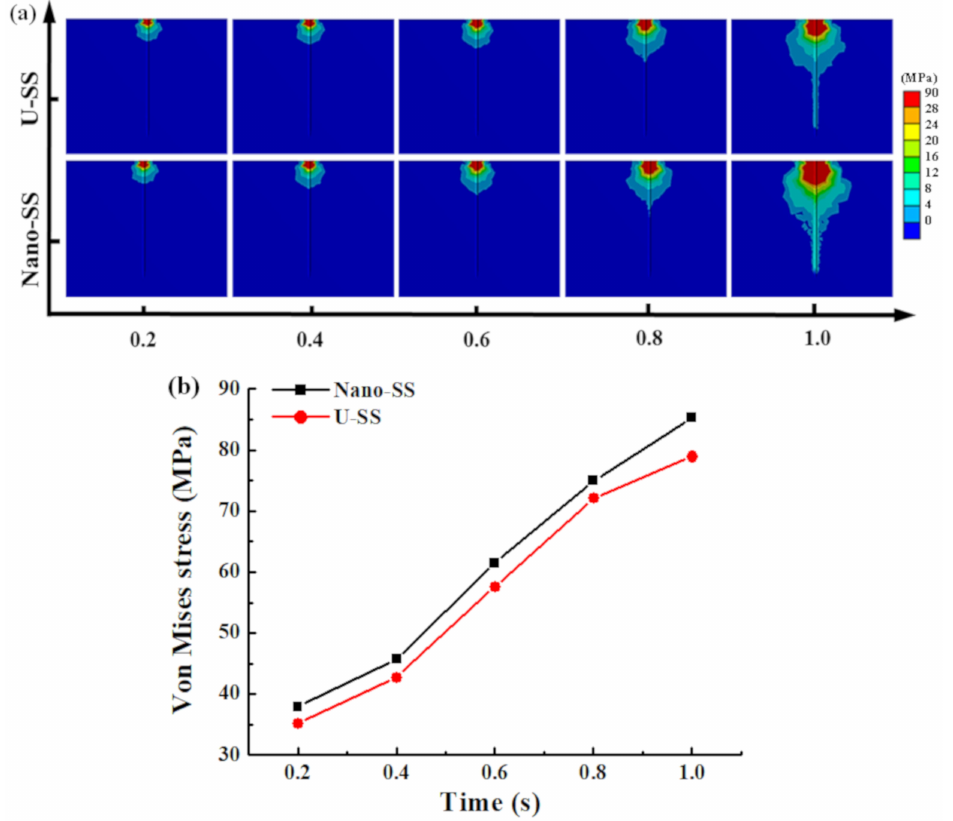
Figure 4. ( a ) Stress distributions of Nano-SS and U-SS in the skin, and ( b ) the highest stress for 1